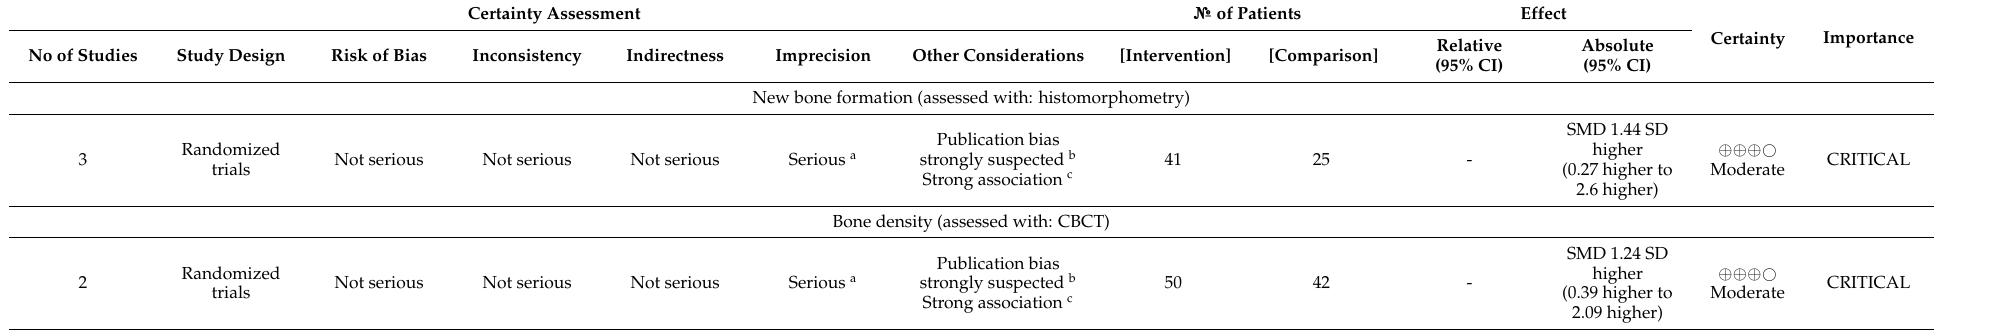
Table 4. Summary of the quality assessment using the GRADE approach of outcomes included in the meta-analysis of PRGF. Certainty Assessment